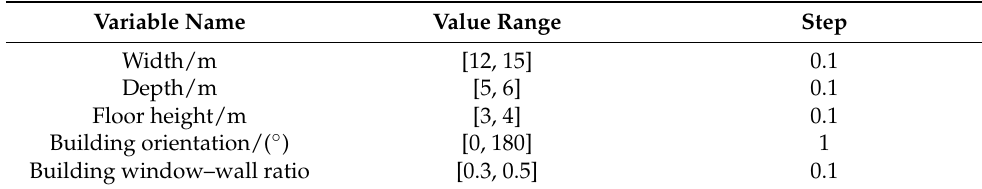
Table 5. Variable parameter